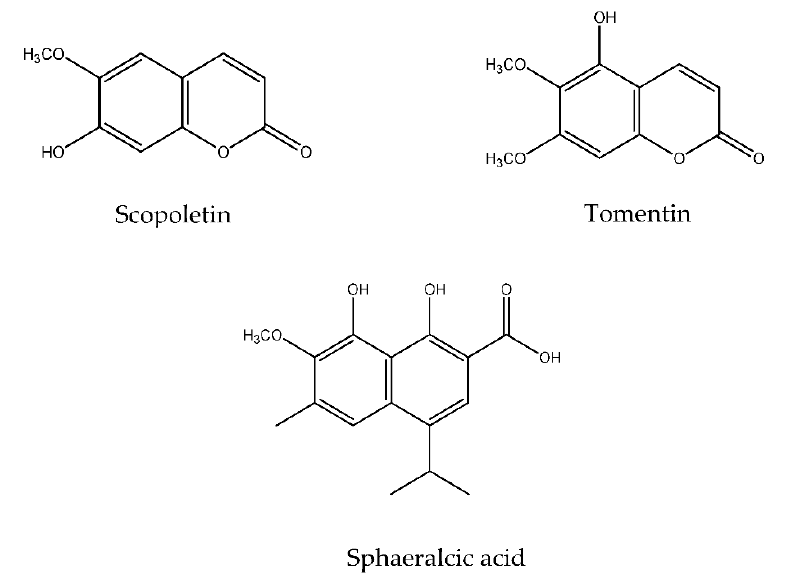
Figure 1. Chemical structures of active compounds standardized in the SaTSS fraction obtained from the Sphaeralcea angustifolia cell suspension [15].